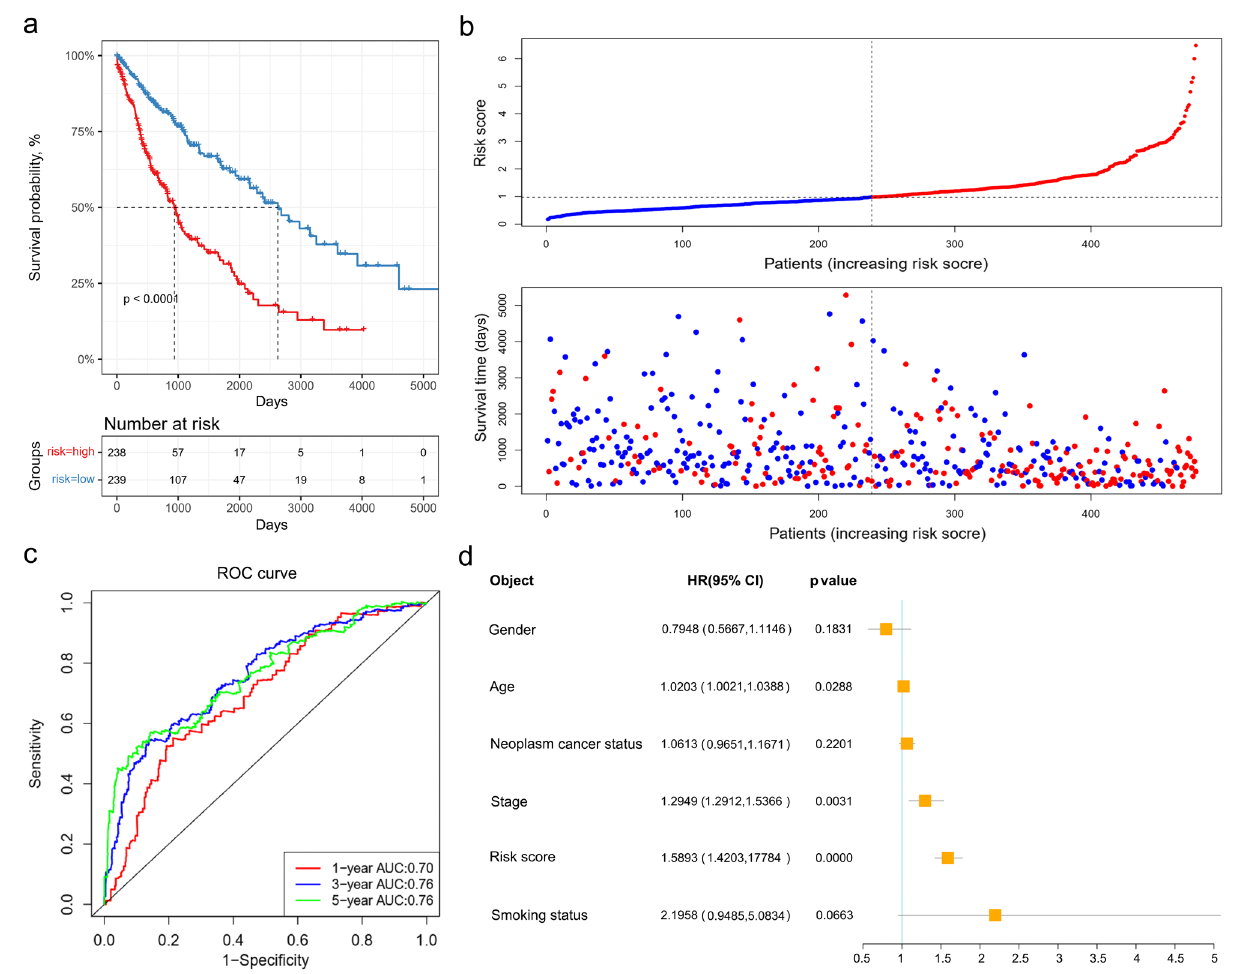
Figure 6. Validation of the 13-gene prognosis signature in The Cancer Genome Atlas cohort. ( a ) Kaplan–Meier curves of overall survival of the high- and low-risk groups. The p value is based on the log-rank test. ( b ) The distribution of risk scores, patient relapse status and survival time. In the upper panel, the red color represents the high-risk group and the blue color represents the low-risk group. In the lower panel, red dots represent dead patients and blue dots represent alive patients. ( c ) Receiver operating characteristic curve (ROC) for the 1-, 3-, and 5-year survival prediction using the 13-gene signature. AUC area under the ROC curve. ( d ) Multivariate cox analysis shows the hazard ratios of the 13-gene signature and other clinico-pathological factors with forest plots.